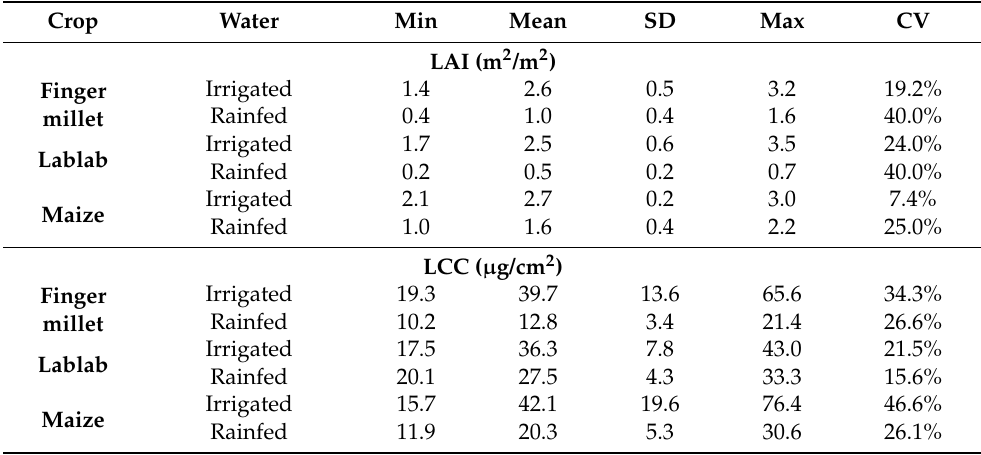
Table A1. Summary of the crop parameter data (LAI: leaf area index, LCC = leaf chlorophyll